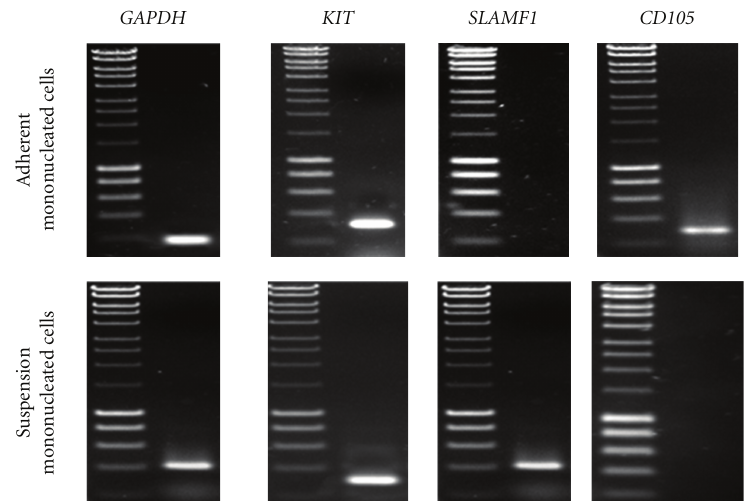
Figure 2: Expression of hematopoietic stem cell (HSC) and mesenchymal stem cell (MSC) markers in mononucleated cells derived from peripheral blood. RT-PCR analysis was performed using total RNA isolated from adherent and suspension mononucleated cells of human peripheral blood. CD105 was used as an MSC marker, SLAM F1 as an HSC marker, and KIT as a stem cell factor (SCF) marker. GAPDH was used as a positive control for RT-PCR analysis. A 100 bp DNA ladder was used to identify the approximate size of the RT-PCR products. The RT-PCR products were observed by electrophoresis on 1% (w/v) agarose gels and stained with ethidium bromide. All RT-PCR products were confirmed with DNA sequencing after cloning and were found to be 100% identical to the known sequences obtained from BLAST analysis.